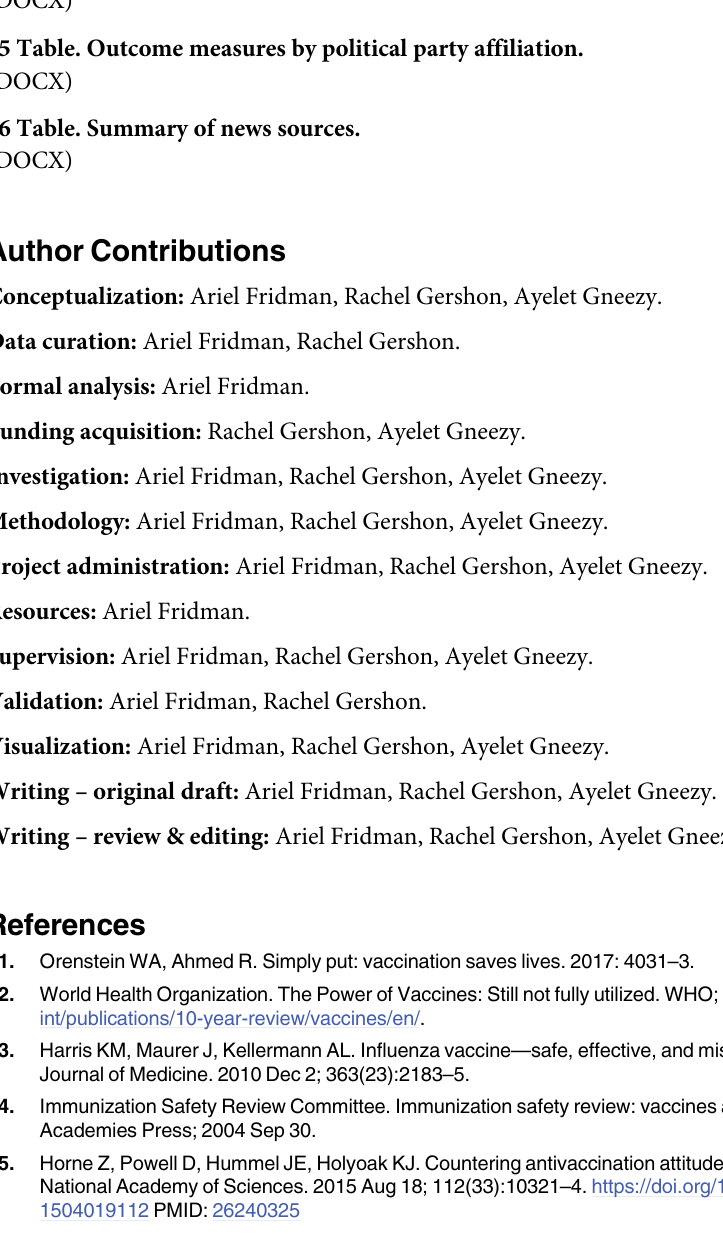
S1 Table. Attrition table. S2 Table. Summary table of measures and constructs included in the text. S3 Table. Summary table of measures excluded from the text. S4 Table. Regression results. S5 Table. Outcome measures by political party affiliation. S6 Table. Summary of news